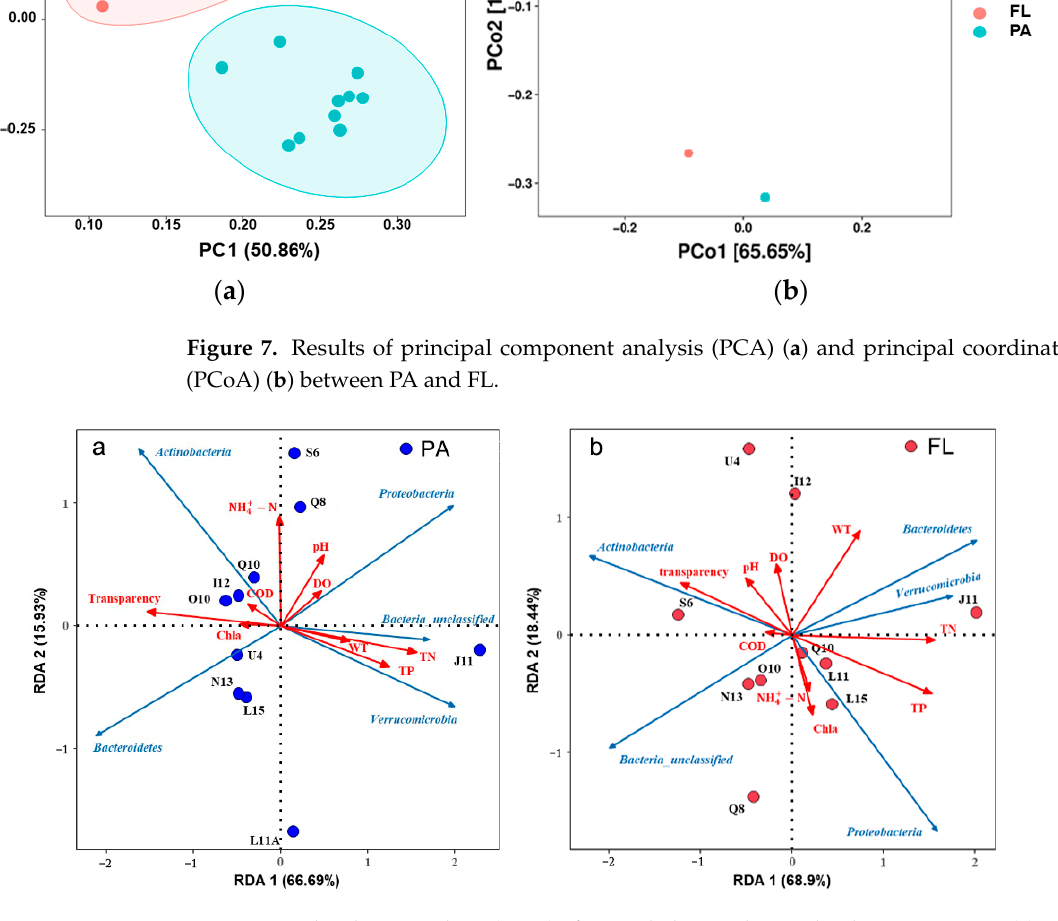
Table 1. Mantel test of bacterial abundance and environmental factors. Index